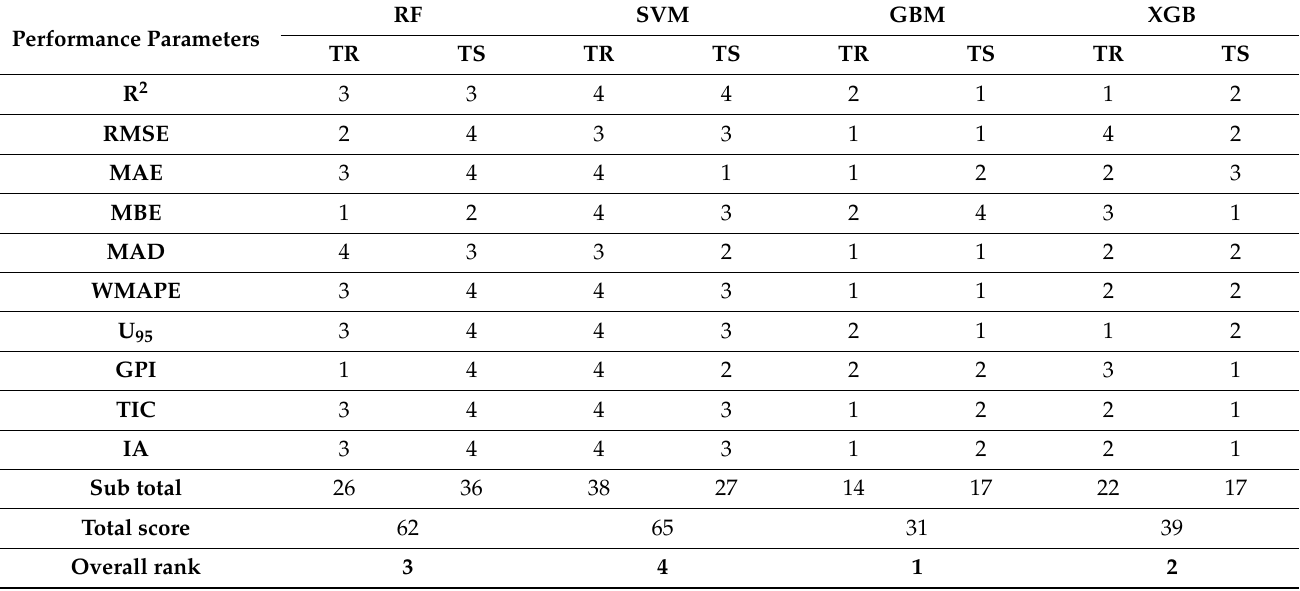
Table 8. Overall rank analysis of different performance parameters for different machine learning